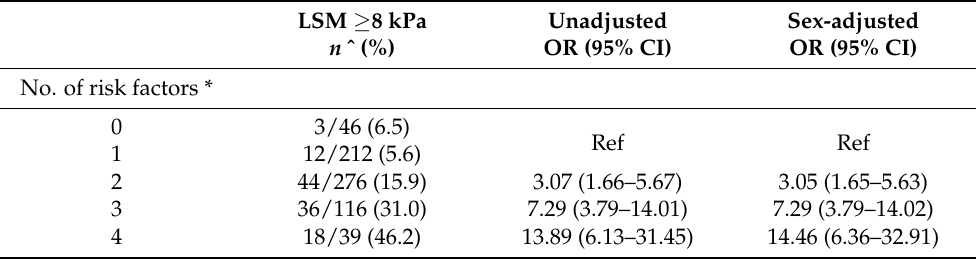
Table 4. Odds ratios (OR), and corresponding 95% confidence intervals (CI), of increased liver stiffness (LSM ≥ 8 kPa) by transient elastography according to the number of risk factors for LSM ≥ 8 kPa * in 699 NAFLD patients with FIB-4 < 1.3.